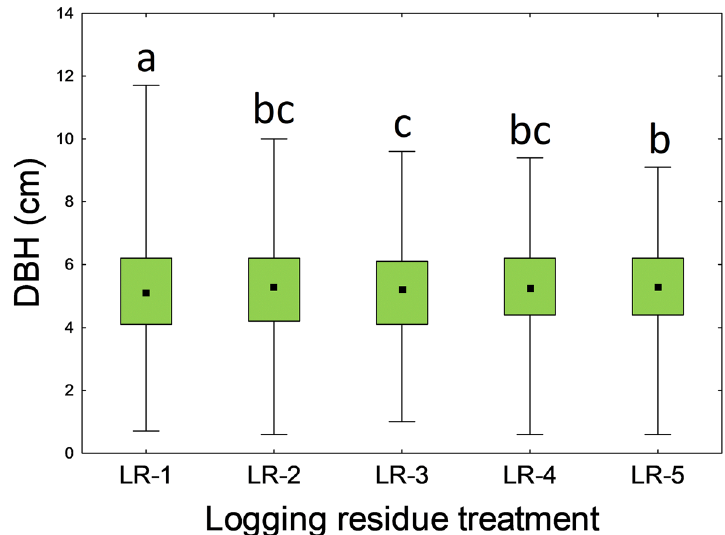
Fig. 4 Mean ( 95% confidence interval) DBH for five logging residue treatments (at 12 years of age): complete removal (LR‑1), incineration (LR‑2), ± leaving whole on surface (LR‑3), comminution and leaving on surface (LR‑4), and comminution and mixing with topsoil (LR‑5). Results of the ANOVA are presented. Different letters indicate significant differences (Tukey’s honestly significant difference test) among methods of site preparation ( p < 0.05)